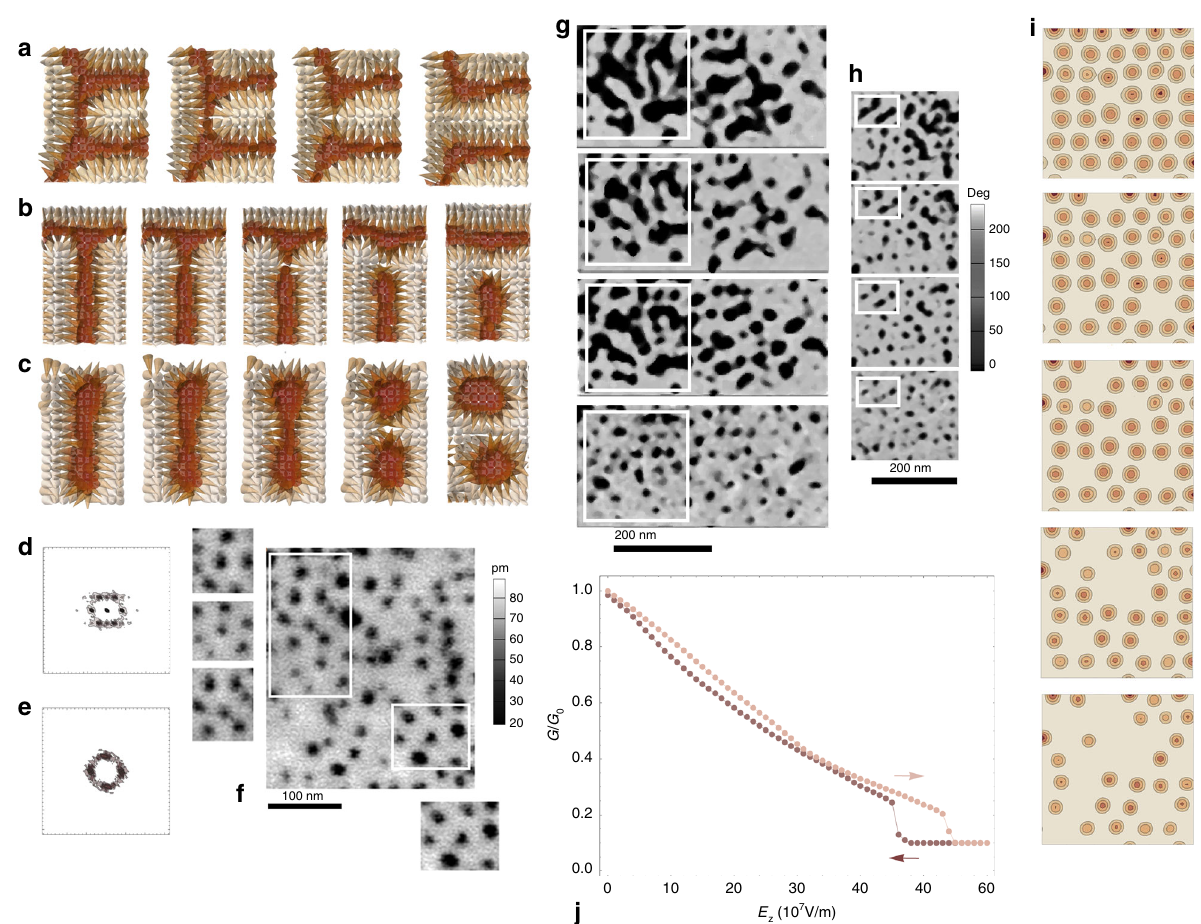
Fig. 4 Topological transitional mechanisms and history dependence. Numerical onsets at 10 K of the disconnection processes of domains via the removal of a a fourfold junction, b threefold junction, and c the cleavage of an elongated bimeron into two skyrmions. For each division process, panels correspond to consecutive snapshots of the middle layer of Pb(Zr 0.4 Ti 0.6 )O 3 80 × 80 × 5 thin fi lm obtained upon increasing fi eld magnitude at 10 K. d , e show the calculated structure factors at 10 K of the labyrinthine domain pattern (phase I) and of the skyrmion lattice (phase IV). f Experimental evidence at room temperature of the quasi-hexagonal arrangement of polar skyrmions as can be seen in PFM amplitude images of the PZT sandwich thin fi lm. g , h show experimental realizations of the pattern evolution involving fourfold and threefold, and bimeron, respectively, at room temperature. Figures correspond to PFM phase images where dark to bright contrast indicates a 180° phase difference, and were obtained through successive scans under a DC bias of 1.8 V. i Progressive depletion of the skyrmions lattice upon increasing of the fi eld within the range of values triggering the transition from phases IV – V, i.e., the transition from the skyrmions lattice to the monodomain state at 10 K. Bright to dark colors correspond to increasing the out-of-plane component of local dipoles. j Electric fi eld hysteresis of normalized tunneling conductance G / G 0 at 10 K. The reference tunneling conductance G 0 corresponds to the zero- fi eld labyrinthine